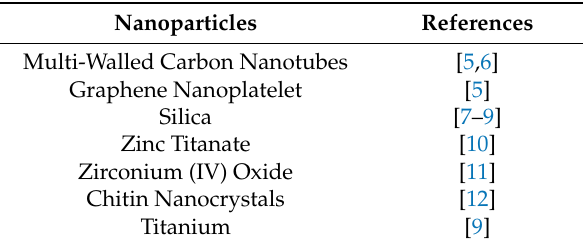
Table 1. Recent research on nanotechnology in drilling mud